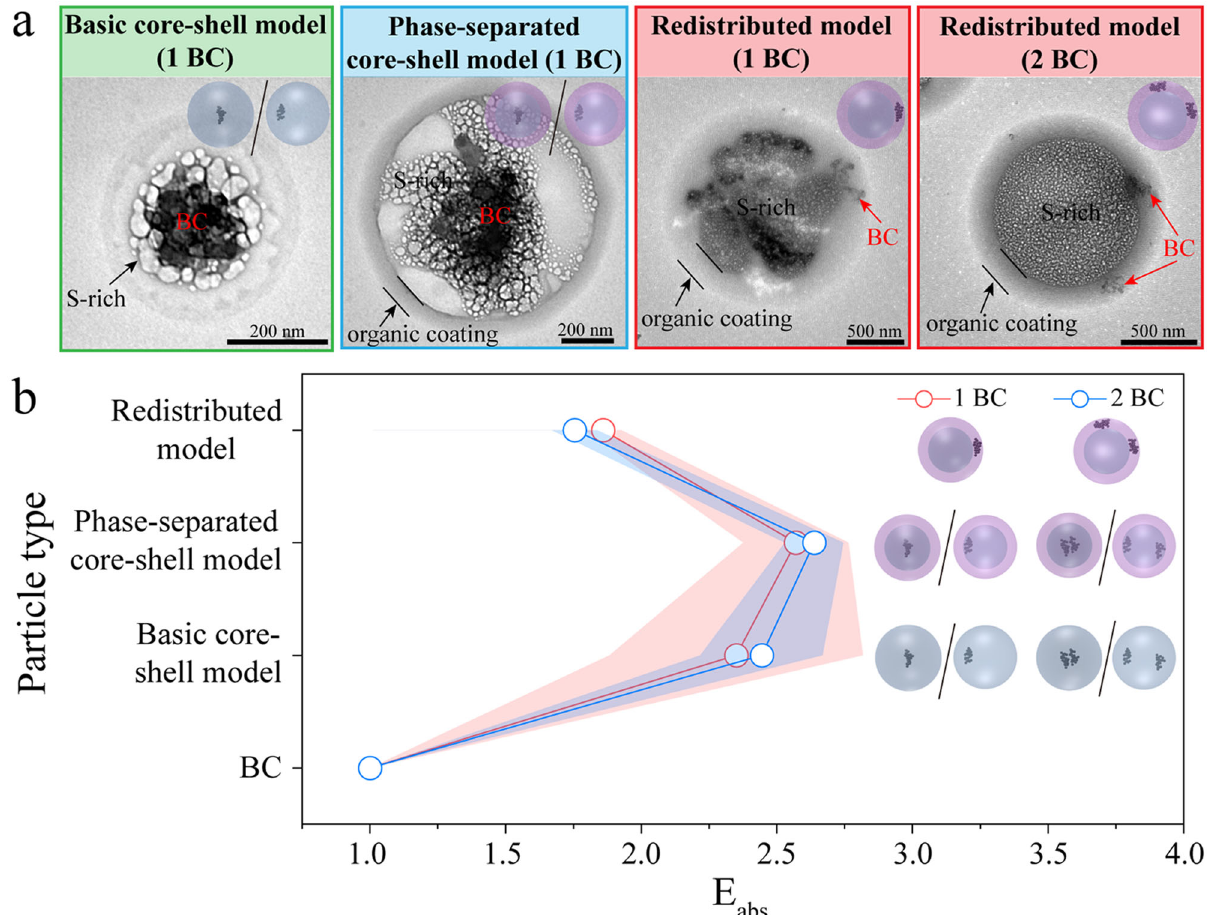
Fig. 5 Light absorption enhancement of BC-in-Icore and BC-in-Ocoating particles. a Three types of internally mixed BC particles (BC-in-Icore without organic coating (basic core-shell model), BC-in-Icore with organic coating (phase-separated core-shell model), and BC-in-Ocoating (redistributed model)) containing one or two BC particles with their models in the upper right corners. The basic core-shell model includes two types: BC in the center and in the eccentric area of individual particles. The phase-separated core-shell model also includes two types: BC in the center and touching the interface between the organic and inorganic phases of individual particles. b Absorption enhancement (E abs ) of the basic core-shell model, phase-separated core-shell model, and redistributed model containing one and two BC particles. The organic coating is assumed to be the non-absorbing organic aerosol. The red and blue shadows indicate the standard deviation of the E abs